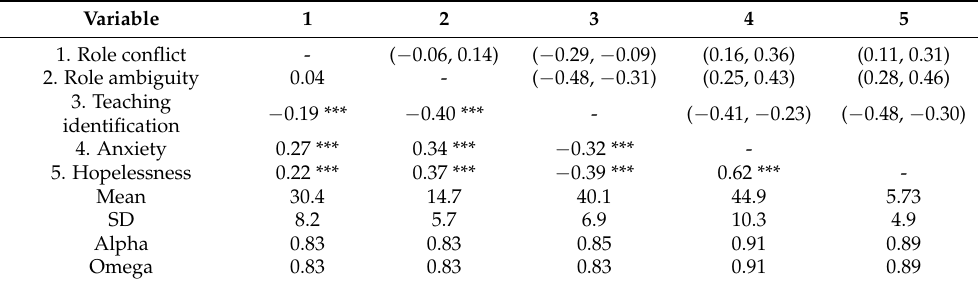
Table 2. Descriptive statistics, reliabilities, and intercorrelations between study